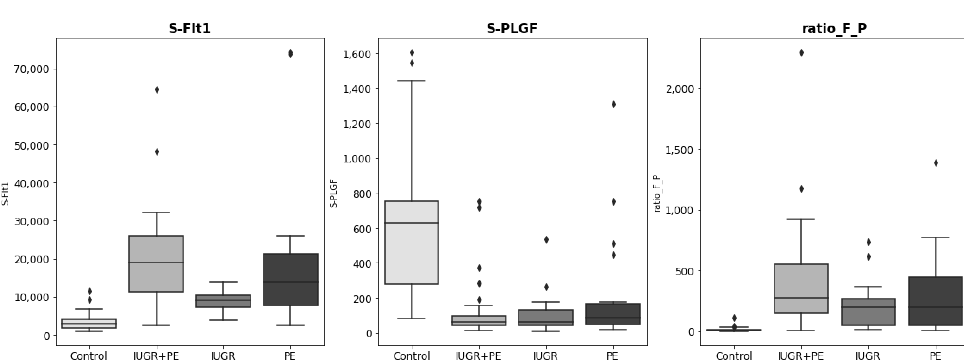
Figure 3. Distribution of sFlt-1, PlGF, and sFlt-1/PlGF ratio by class. The lozenge symbol (cid:169) represents the outliers values of each measure.